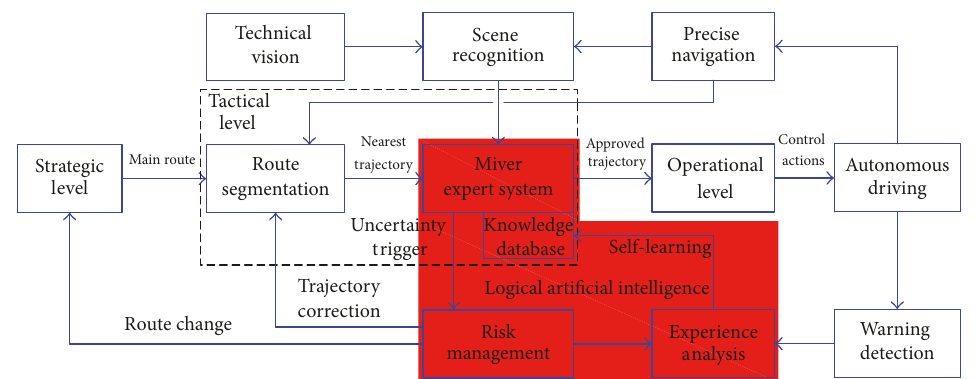
Figure 8: Principal scheme for integration of Logical Artificial Intelligence into an autonomous driving control system.